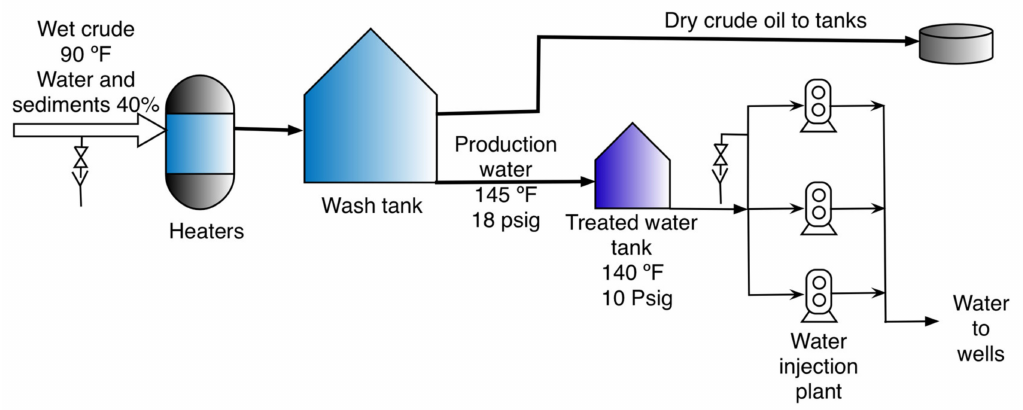
Figure 25. Separation scheme of production water and water injection